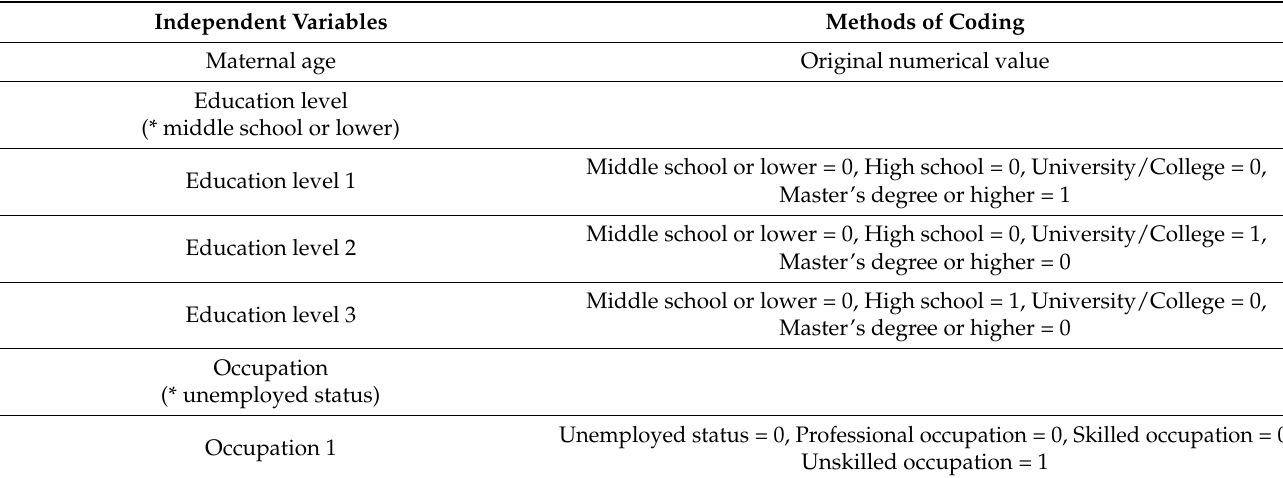
Table 1. The coding of independent variables in the regression